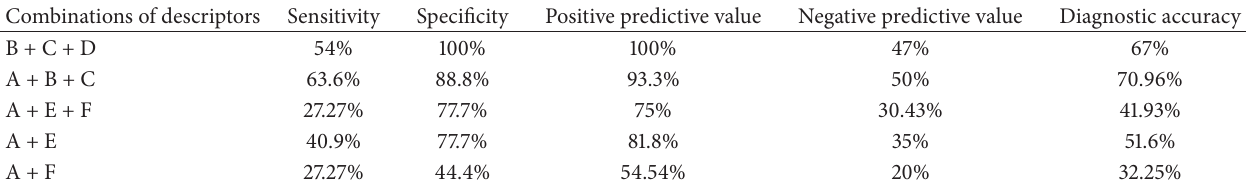
Table 2: Accuracy of combinations of predictors to evaluate the metastatic involvement of axillary lymph